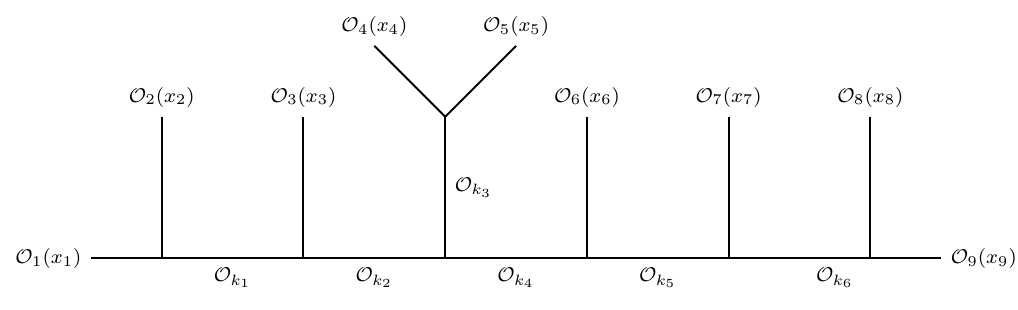
Figure 21 . 9-point asymmetrical mixed conformal block.